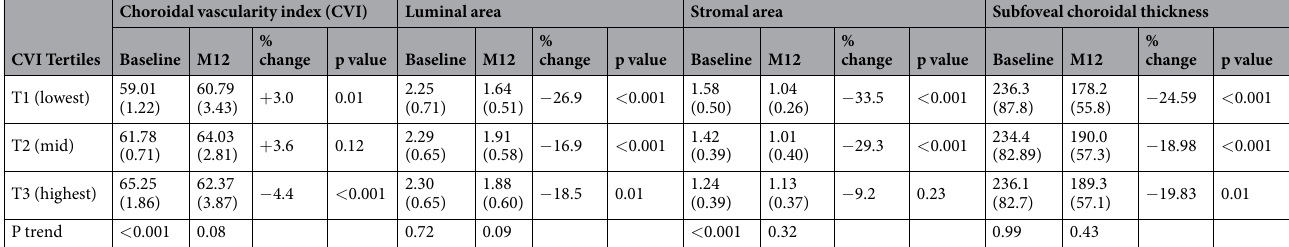
Table 3. The change of choroidal vascularity index, luminal area, stromal area and subfoveal choroidal